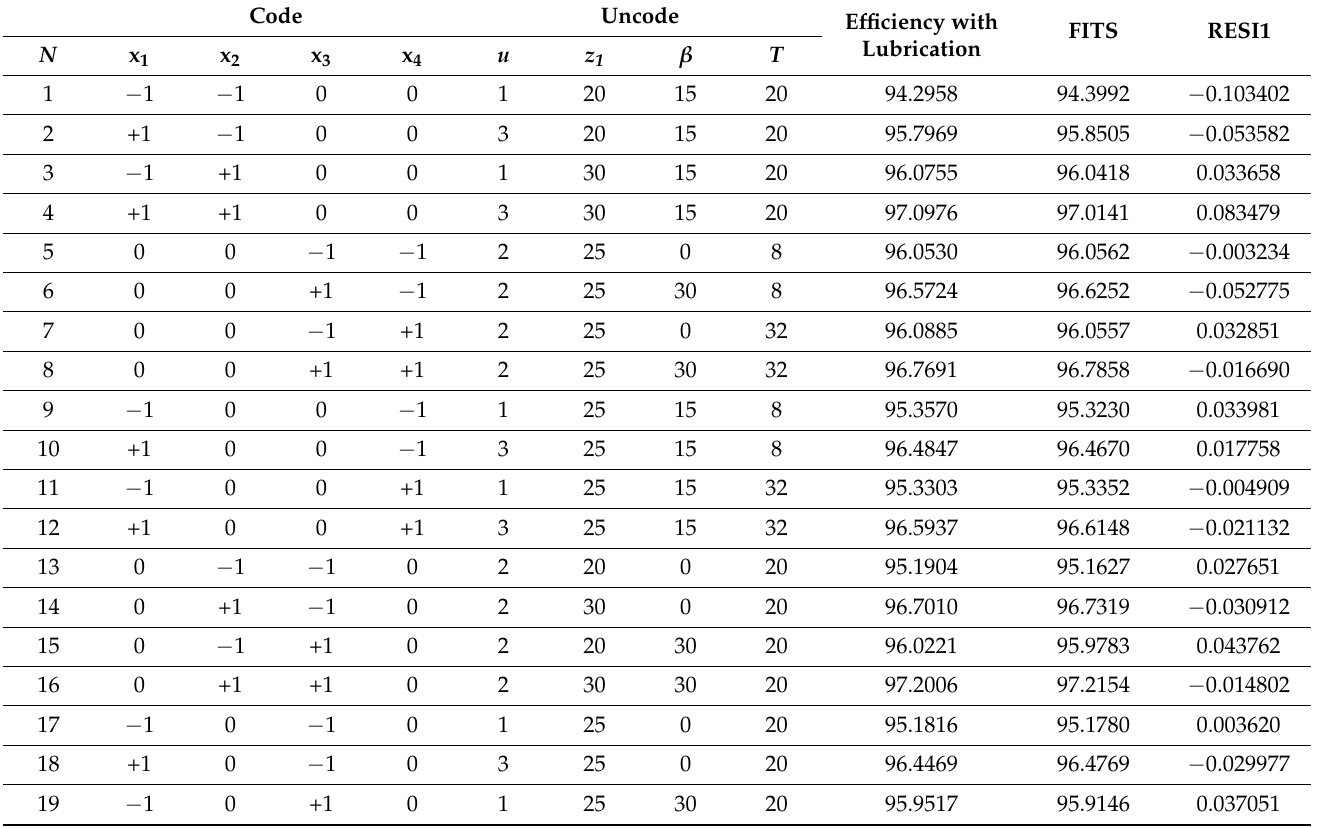
Table 3. Design matrix and experimental